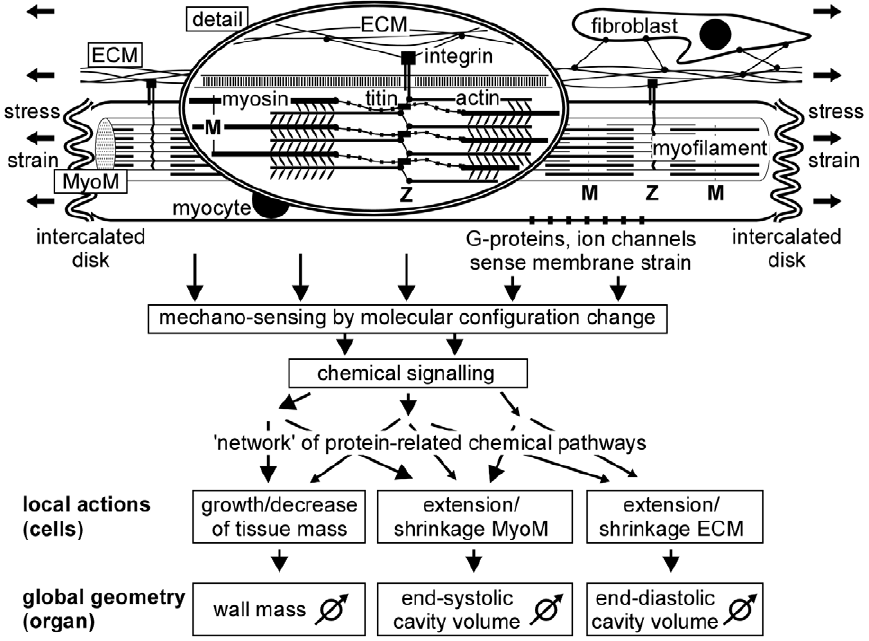
Figure 1. Schematic of adaptation of wall geometry to mechanical load. Global stress and strain of the tissue determine forces and deformation of the myocyte matrix (MyoM) and extracellular matrix (ECM). Within the myocyte, axial forces are born by the sarcomeres in the myofilaments, consisting of actin and myosin, mutually coupled by cross-bridges. The Z-disk connects actin and titin of neighboring sarcomeres. The distance between Z-discs represents sarcomere length, ranging from 1.7 to 2.3 m m. Titin parallels actin, and is connected to myosin. The Z-disks are connected transversely to the ECM by integrins, traversing the cell membrane of the myocyte. Mechano-sensing has been reported around the Z- disk, within the cell membrane of the myocyte and in the intercalated disks, forming axial connections between myocytes. Fibroblasts are also mechano-sensitive. Resulting chemical signals follow a network of intertwined pathways of chemical activity, resulting in local actions of adaptation. Summed effects of local actions determine global changes in geometry of the myocardial